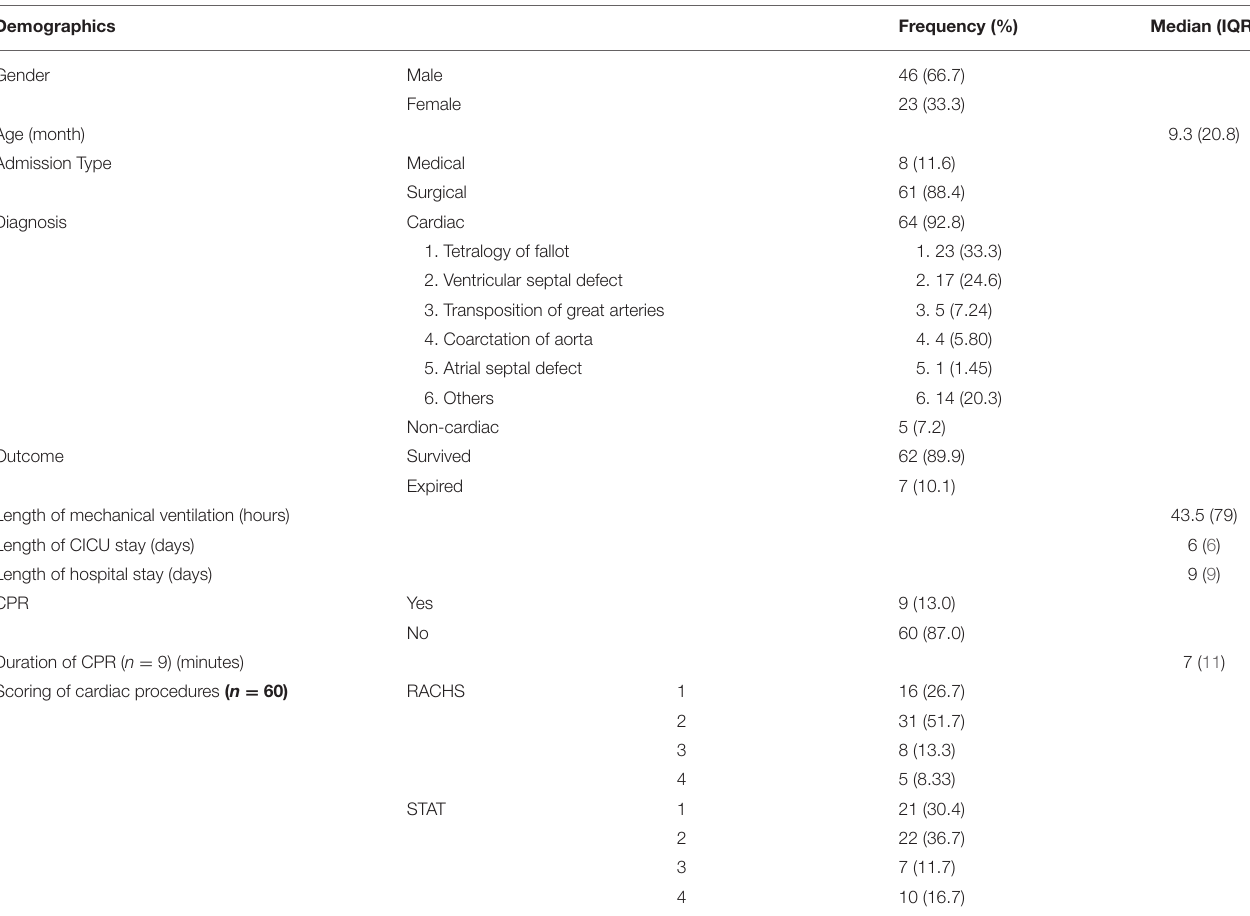
TABLE 1 | Demographic details of study population ( n =